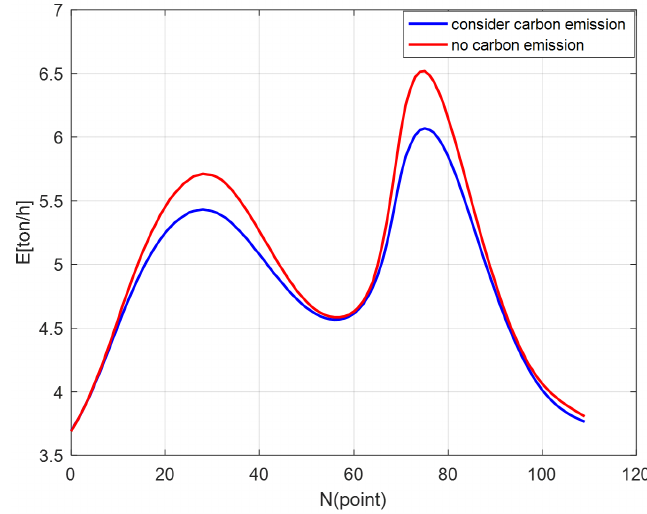
Figure 9. Energy with carbon emissions added and no carbon